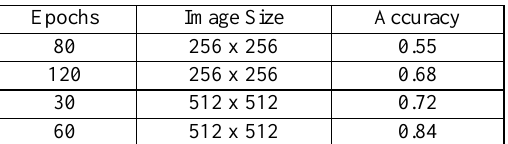
Figure 11. Accuracies of Transfer Learning on Raw images